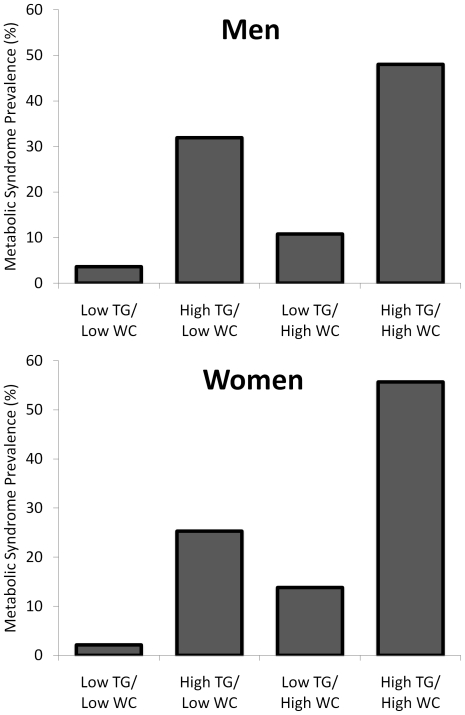
Metabolic syndrome prevalence among HIV-infected men (top panel) and women (bottom panel) according to WC and TG category.Bars represent prevalence (%).Bars with the same inset letter are not statistically different from one another (p>0.05). All other comparisons are significant (p<0.05).